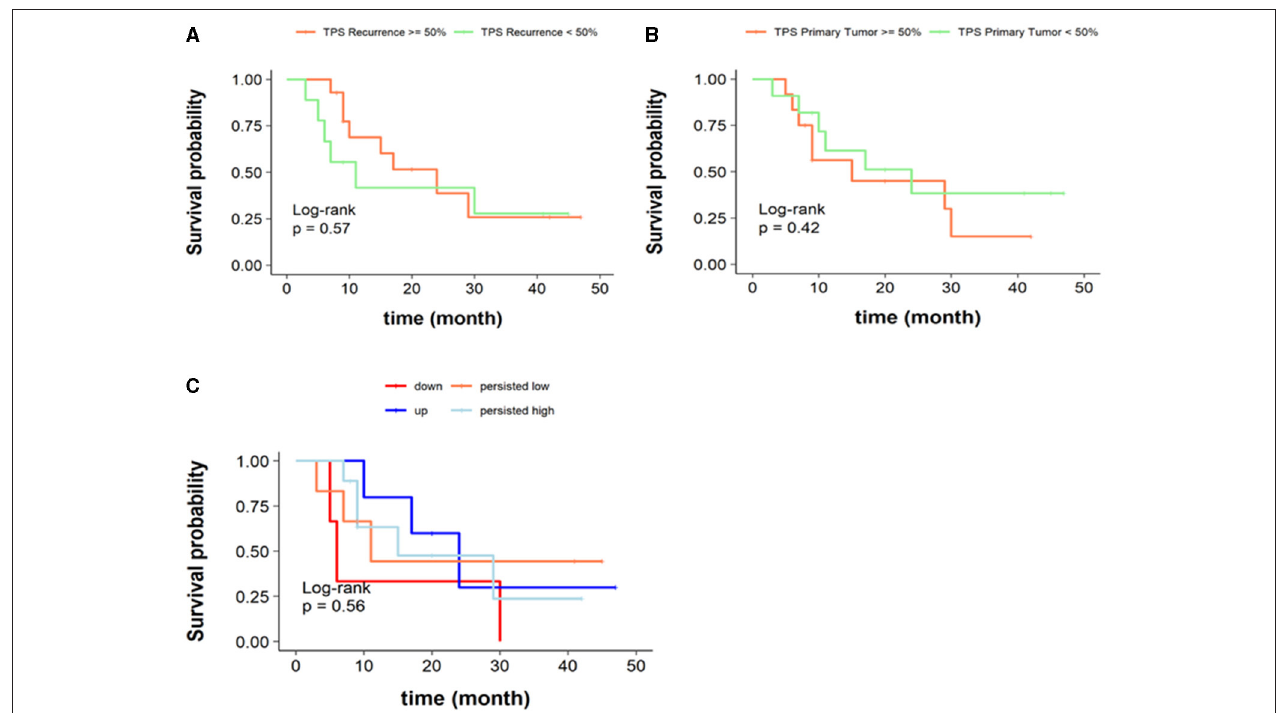
FIGURE 4 | Overall survival according to DLL3 expression status. (A) Kaplan–Meier curves stratified according to DLL3-high or DLL3-low status assessed with TPS in chemorelapsed specimens (log-rank p = 0.57). (B) Kaplan–Meier curves stratified according to DLL3-high or DLL3-low status assessed with TPS in chemonaive specimens (log-rank p = 0.42). (C) Kaplan–Meier curves stratified according to dynamics of DLL3 expression in the course of therapy. Persisted DLL3-low was defined as TPS < 50% in chemonaive and chemorelapsed samples, persisted DLL3-high was defined as TPS ≥ 50% in chemonaive and chemorelapsed samples, “up” was defined as a switch from TPS < 50% to ≥ 50%, and “down” was defined as a switch from TPS ≥ 50% to < 50% in the course of therapy (log-rank test p =